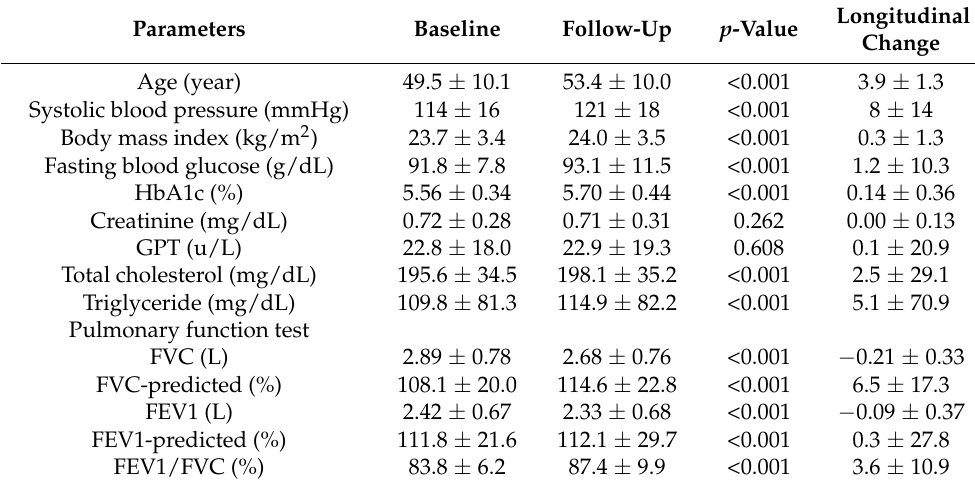
Table 1. Clinical, laboratory, and pulmonary function data in all 7055 study participants.